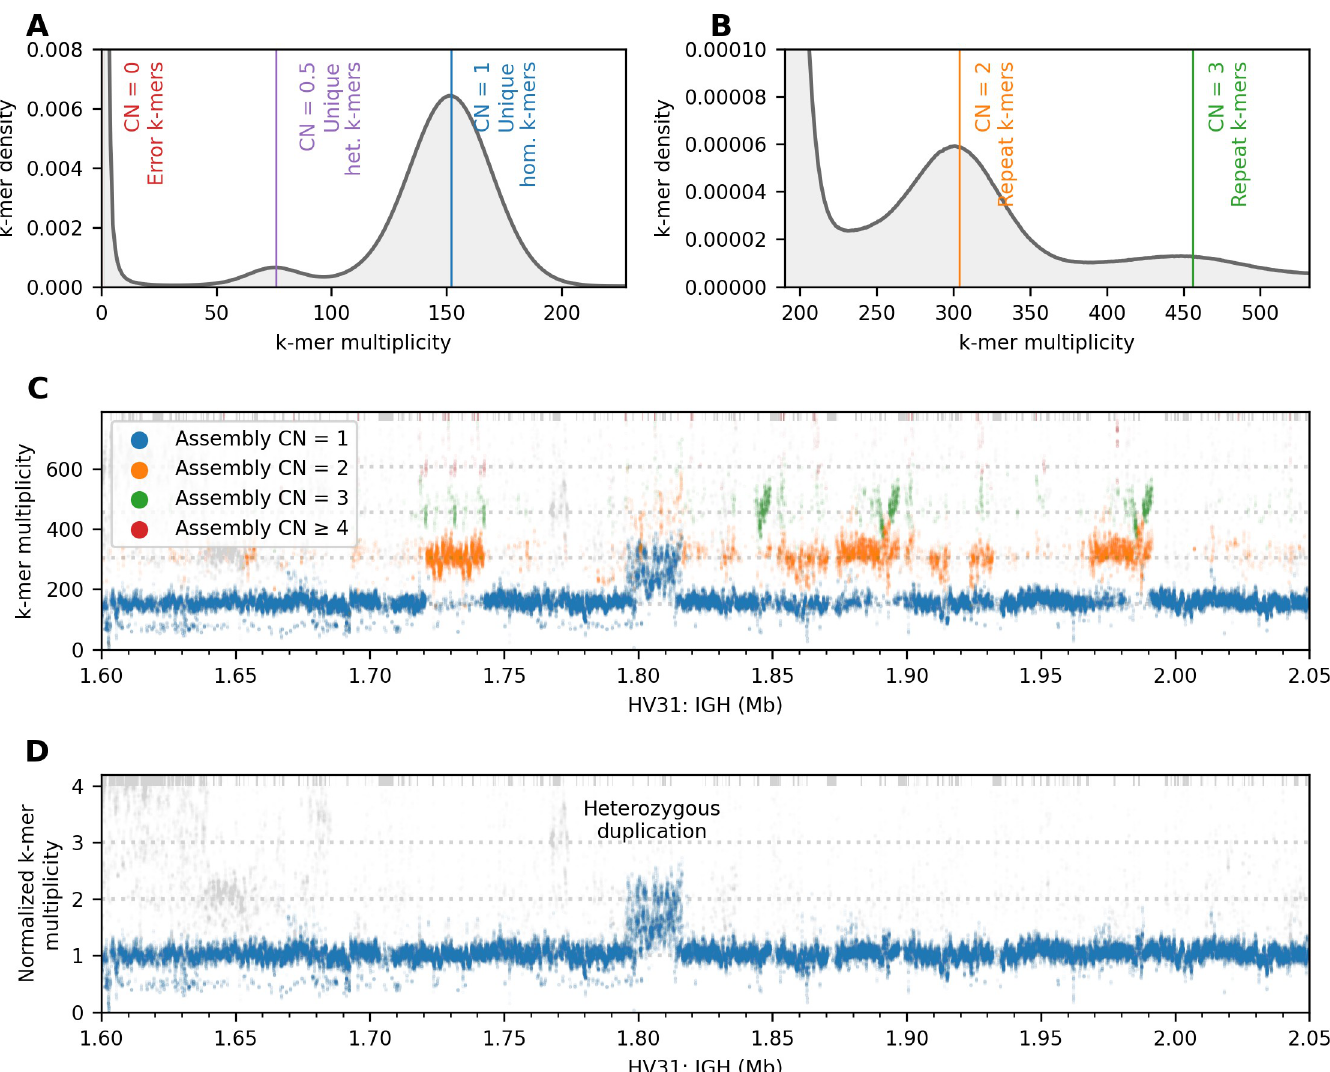
Fig 3. Reference-free assembly validation based on k-mer multiplicity. (A, B) Histogram of k-mer multiplicity (k = 31) in unassembled reads in the validation dataset. Vertical lines show locations of distribution peaks; text indicates interpretation of k-mers near these peaks (het., heterozygous; hom., homozygous; CN denotes assumed true copy number of the k-mer in the diploid HV31 genome). (C) k-mer multiplicity (y axis) plotted against k-mer position for a repeat-rich sequence fragment in the IGH region of the HV31 assembly. Green, blue and purple colors denote the k-mer copy number in the HV31 assembly scaffolds. Non-specific k-mers that are also found outside the IGH region are colored gray. (D) validation k-mer multiplicity normalized against assembly copy number for the same sequence fragment as in (C). To make the y axis center on 1, values are further normalized by dividing by the peak multiplicity of unique homozygous k-mers as shown in panel A. The region of discrepancy indicates a complex heterozygous duplication around IGHV3-30 that we discuss further below. In (C) and (D), k-mers with multiplicity beyond the axis limits are stacked at the top of the plots. Panel A and Panel B in S10 Fig show (C) and (D) extended to all eight regions, respectively.